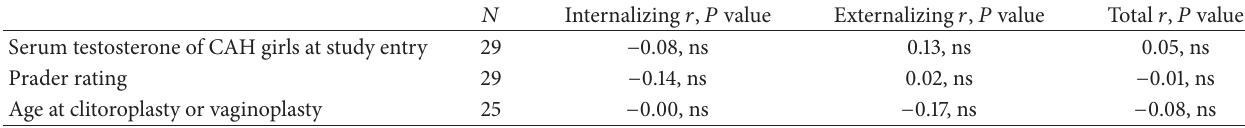
Table 9: Correlations between summary scales 𝑇 scores and disease characteristics in CAH patients.